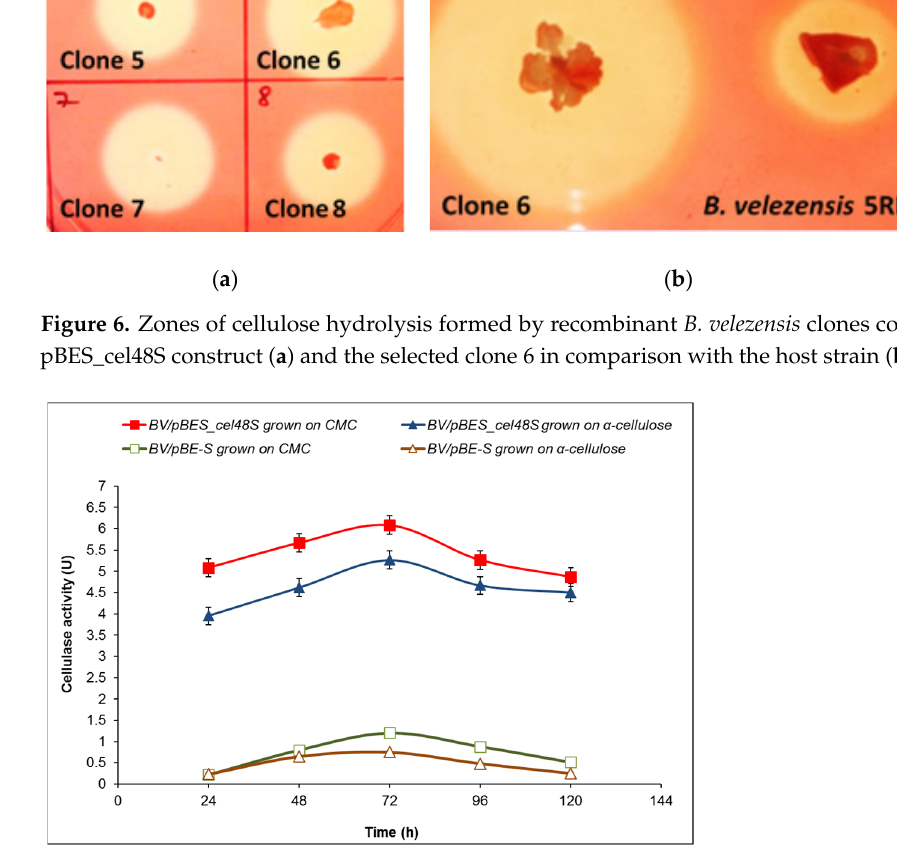
Figure 5. Time course of cellulase activity of B. licheniformis recombinant clones containing the pBES_cel8A construct with a library of signal peptides compared to B. lichenifromis 24 transformed with pBE-S vector (control). The data are mean values from two batch processes.